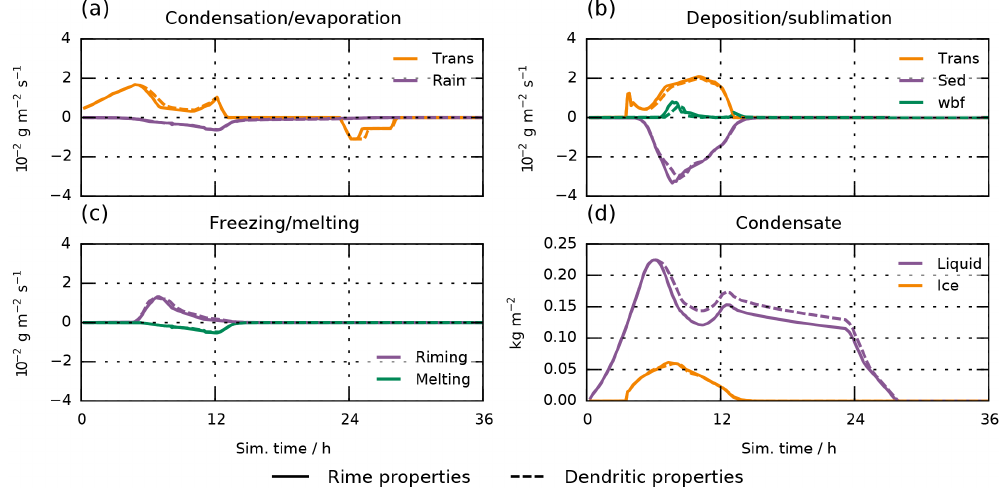
Figure 11. Same as in Fig. 10 but for simulations with the single-category scheme where freezing in the mixed-phase cloud is turned off and the humidity forcing in the cirrus regime is turned on. The solid lines represent a simulation where riming affects the particle properties, and the dashed lines represent a simulation where the mass-to-size relation for dendrites is assumed for all particles with diameter D > D th